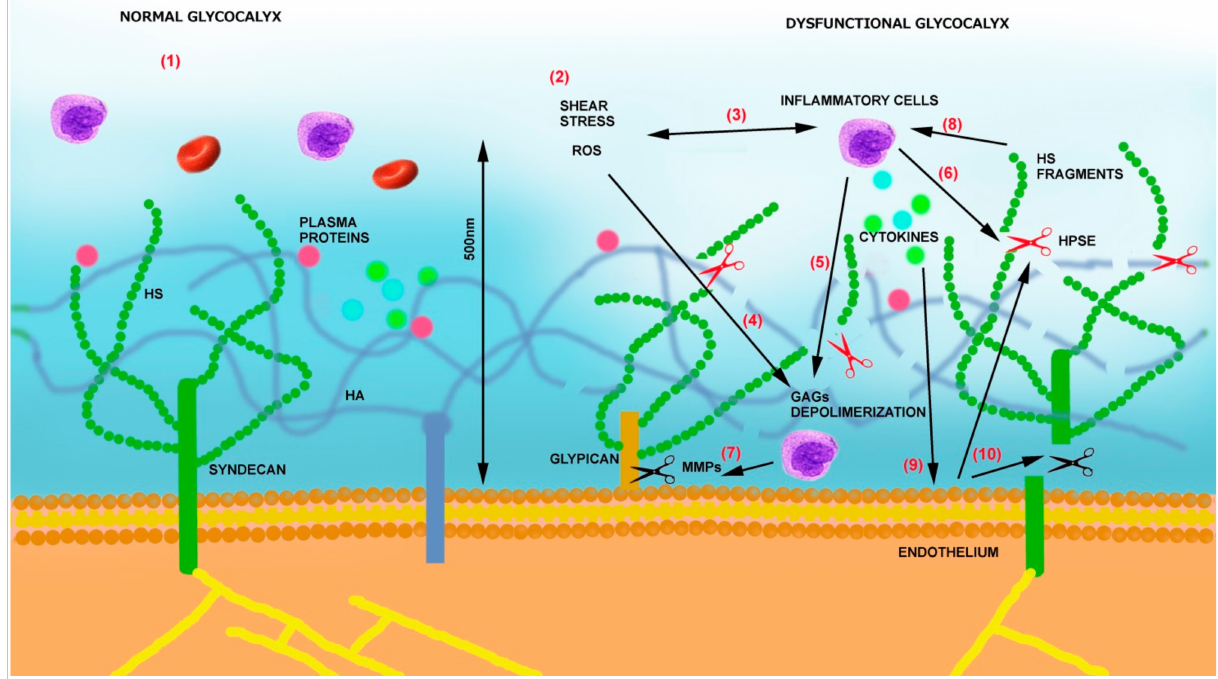
Figure 1. (1) Under physiological conditions, the glycocalyx represents a protective layer of proteoglycans (syndecans and glypicans), glycosaminoglycans (GAGs) (HS—heparan sulfate, HA—hyaluronic acid), and adsorbed plasma proteins. (2) In pathological situations such as atherosclerosis, ischemia, and diabetes, a series of stimuli impact glycocalyx integrity. (3) ROS and shear stress recruit activated inflammatory cells, and inflammatory cells release additional ROS. (4) ROS participates in GAG depolymerization, which aids in (5) leukocyte activation and macrophage extravasation. Activated inflammatory cells release (6) HPSE (red scissors) and (7) matrix metalloproteinases (MMPs) (black scissors). MMPs shed the protein extra-domains of proteoglycans, and HPSE cleaves HS chains. (8) Soluble syndecans and HS fragments additionally activate inflammatory cells (9), which release cytokines. (10) Cytokines and growth factors activate endothelial cells to produce MMPs and HPSE, fueling the